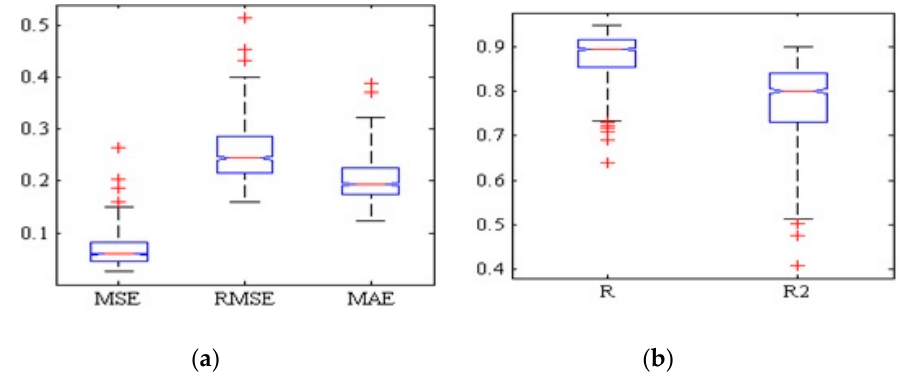
Figure 8. Boxplot of the evaluation criteria of the hybrid ANN–ABC method in estimating the value of firmness on the spectral range around the wavelength of 875 nm at 1000 iterations. ( a ) Error measures: Mean Square Error (MSE), Root Mean Square Error (RMSE) and Mean Absolute Error (MAE). ( b ) Regression coefficients and coefficient, R, of determination, R 2 .